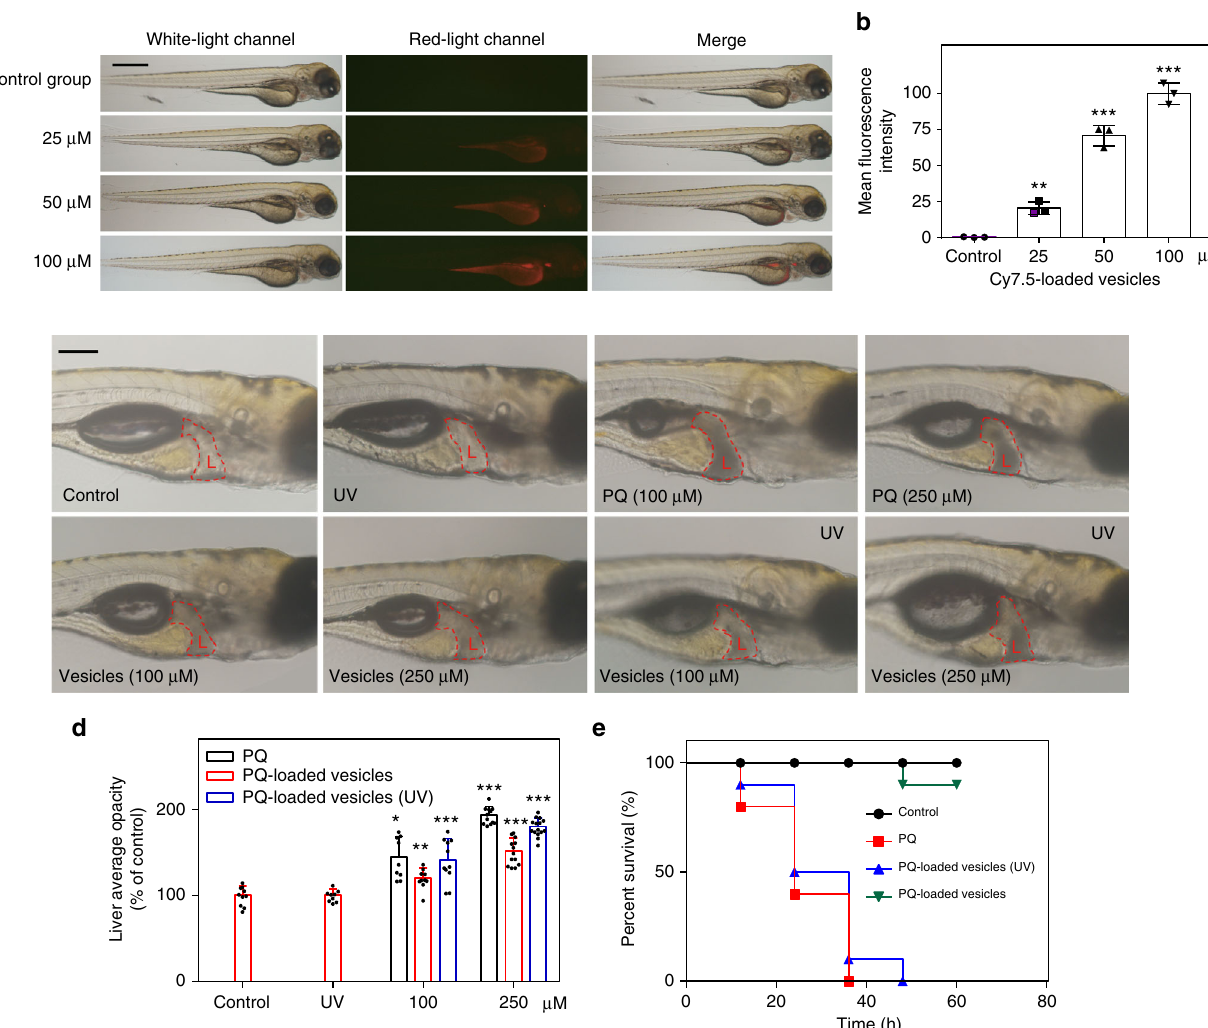
Fig. 4 Safety evaluation of PQ-loaded vesicles in zebra fi sh model. a Two-dpf zebra fi sh incubated with media containing Cy7.5-loaded vesicles of various concentrations for 2 days. Scale bar: 0.6 mm. b Semi-quantitative analysis of bio-uptake of Cy7.5-loaded vesicles. The error bars correspond to the SD ( n = 3). * P ≤ 0.05, ** P ≤ 0.01, and *** P ≤ 0.001 determined by one-way ANOVA; c 2-dpf zebra fi sh incubated with media containing PQ-loaded vesicles with different concentration for 2 days. The red-dotted region refers to the liver tissue. Scale bar: 0.2 mm. d Semi-quantitative analysis of liver average opacity. The error bars correspond to the SD ( n = 9 – 15). * P ≤ 0.05, ** P ≤ 0.01, and *** P ≤ 0.001 determined by Student ’ s t test. e Thirty-dpf zebra fi sh incubated with PQ and PQ-loaded vesicles (2 mM), respectively, for 60 h, with or without UV irradiation ( n = 10 in